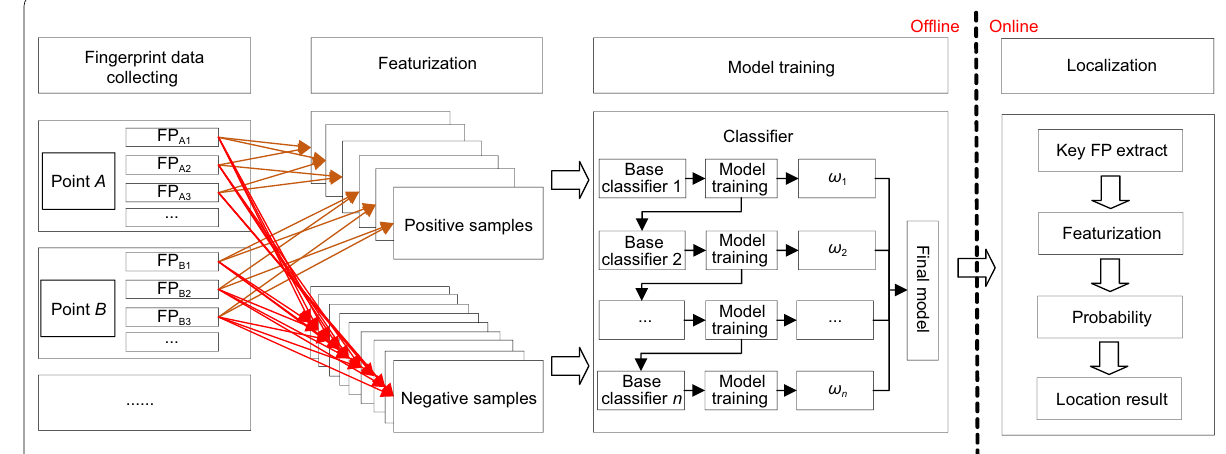
Fig. 1 The components of the whole system